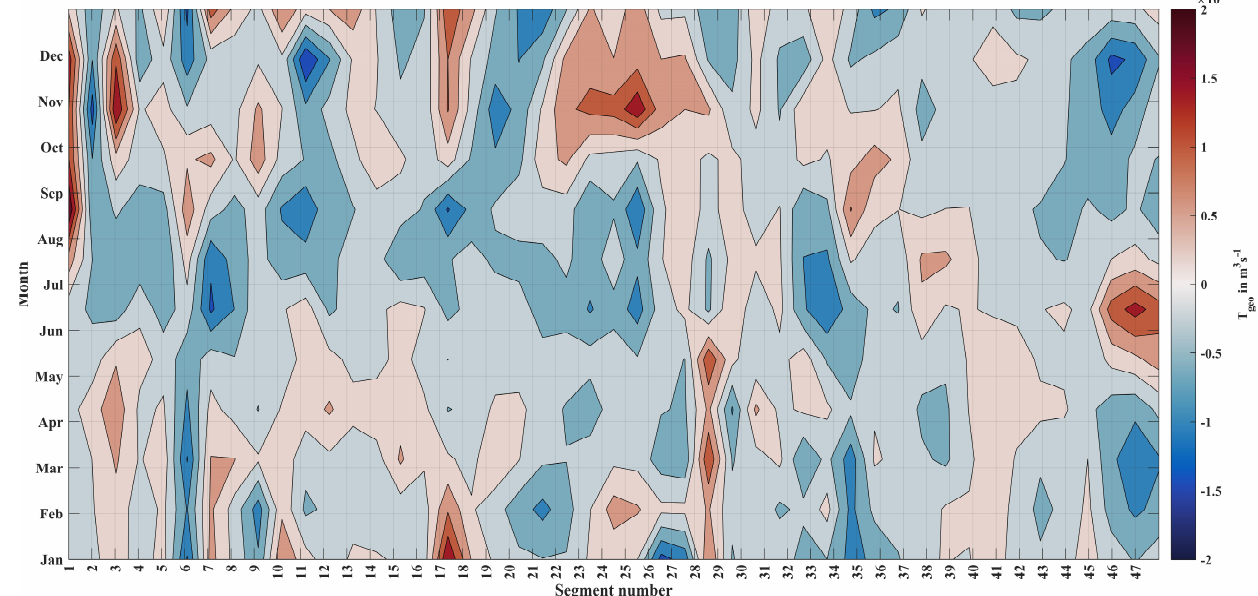
Figure 6. Annual cycles of T geo , calculated for 1993 − 2020. The highest accumulation of maximum geostrophic transport values towards the on- shore region (negative) and o ff shore region (positive) are in the northeastern areas of the Persian Gulf.